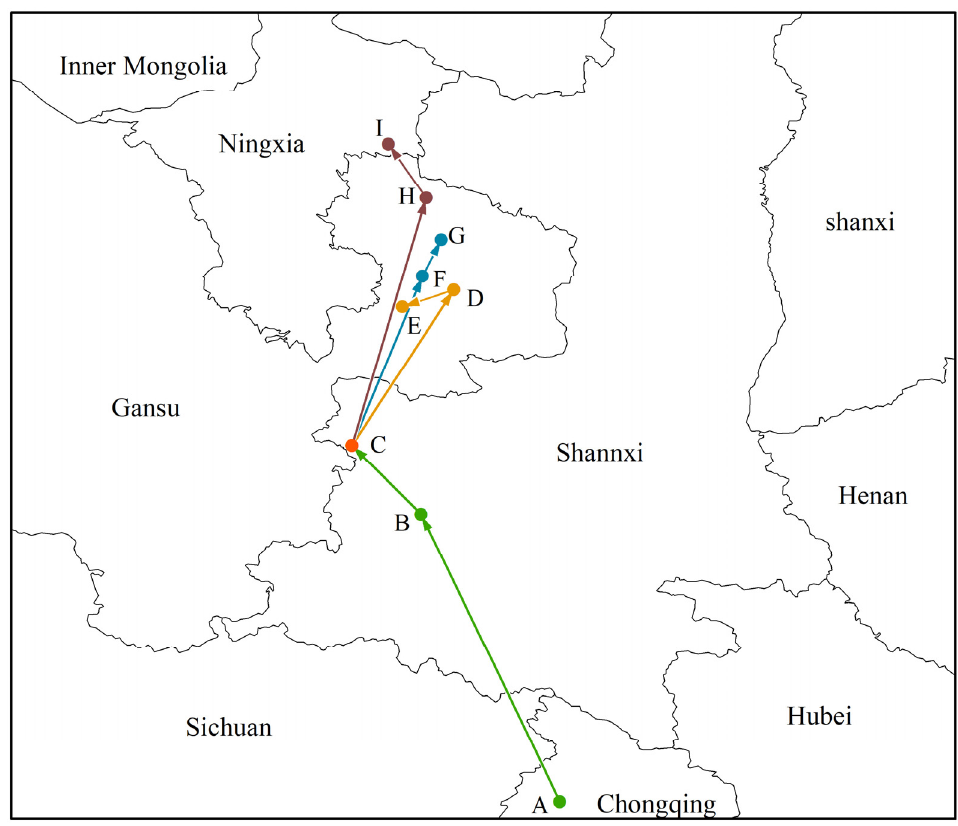
Figure 5. Migratory routes of potential distribution centers of Morchella in the context of climate change. Among them, the meaning of the letters were (A) LGM, (B) MH, (C) current, (D) 2050s—RCP2.6, (E) 2070s—RCP2.6, (F) 2050s—RCP4.5, (G) 2070s—RCP4.5, (H) 2050s—RCP8.5, (I) 2070s—RCP8.5.